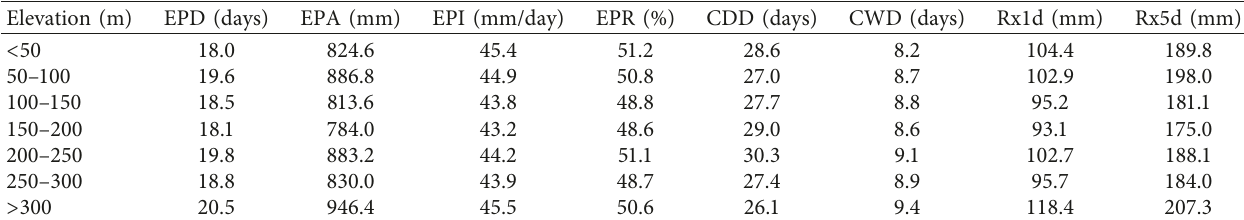
Table 6: Average values of extreme precipitation indices in the categorized elevation